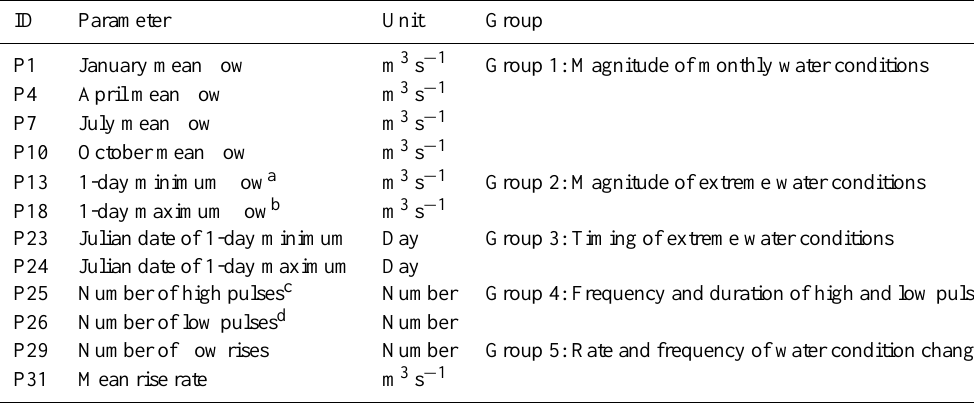
Table 1. Hydrologic parameters of the IHA used in this study.